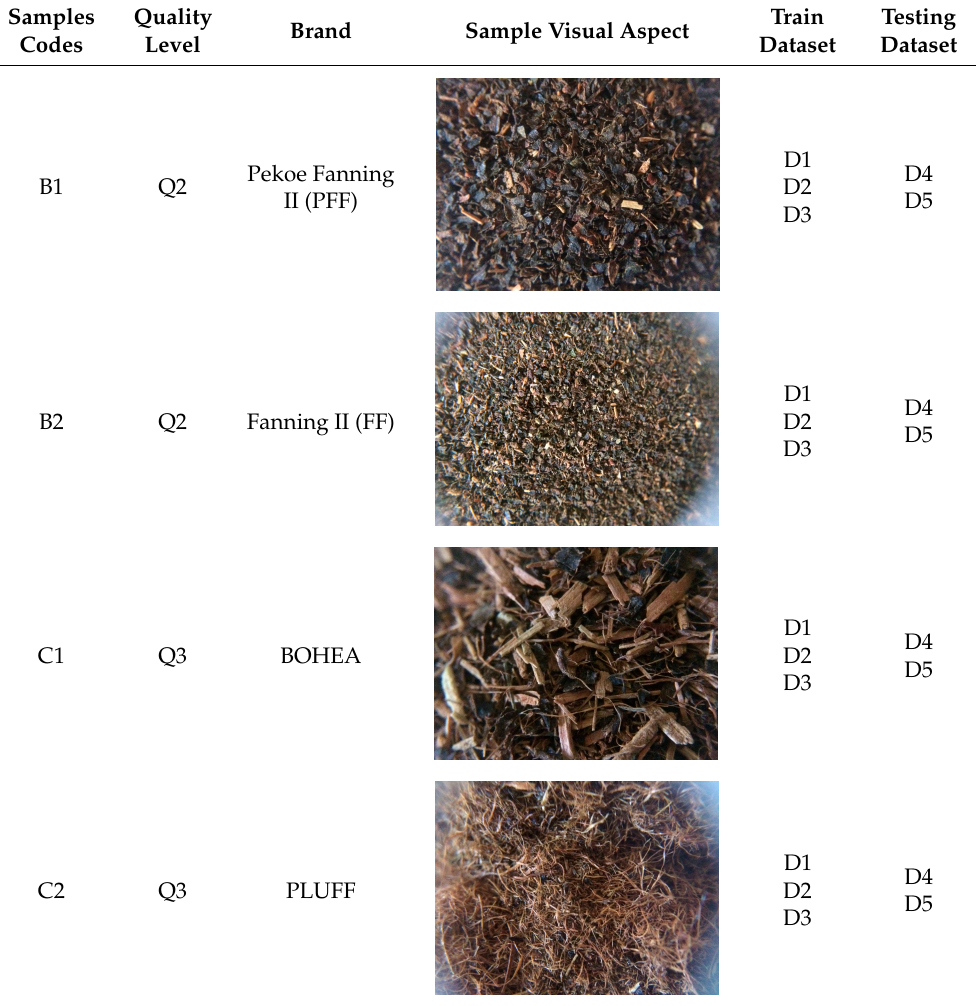
Table 1. List of dried black tea samples. Samples Codes